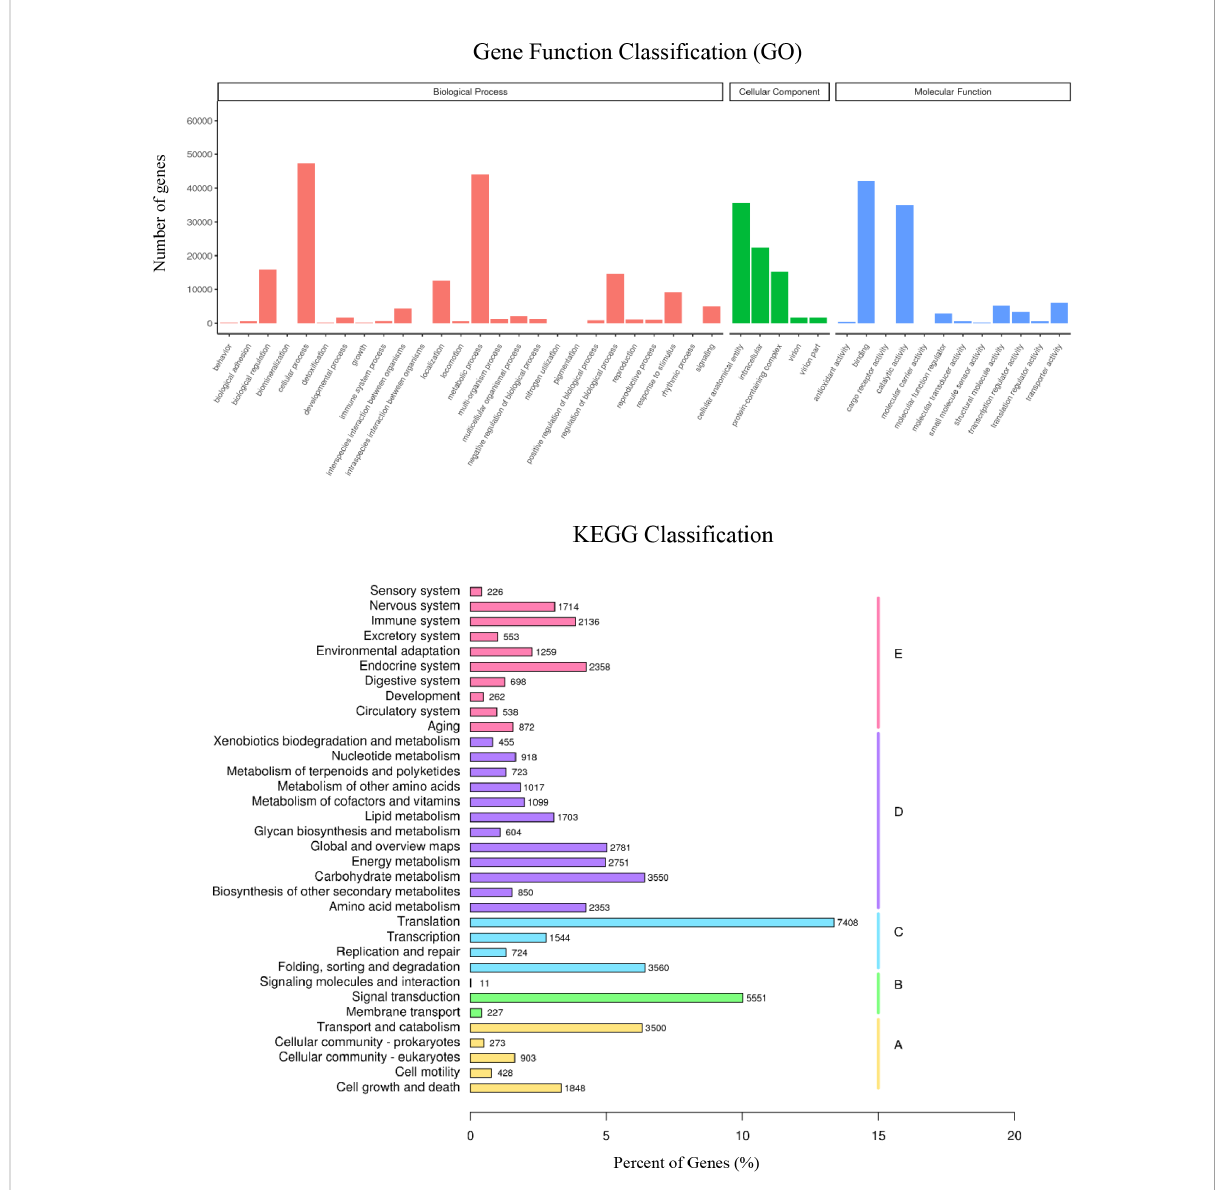
FIGURE 2 Gene Ontology (GO) function and Kyoto Encyclopedia of Genes and Genomes (KEGG) metabolic pathway classi fi cation. A: Cellular Processes, B: Environmental Information Processing, C: GeneticInformation Processing,D: Metabolism, E: Organismal